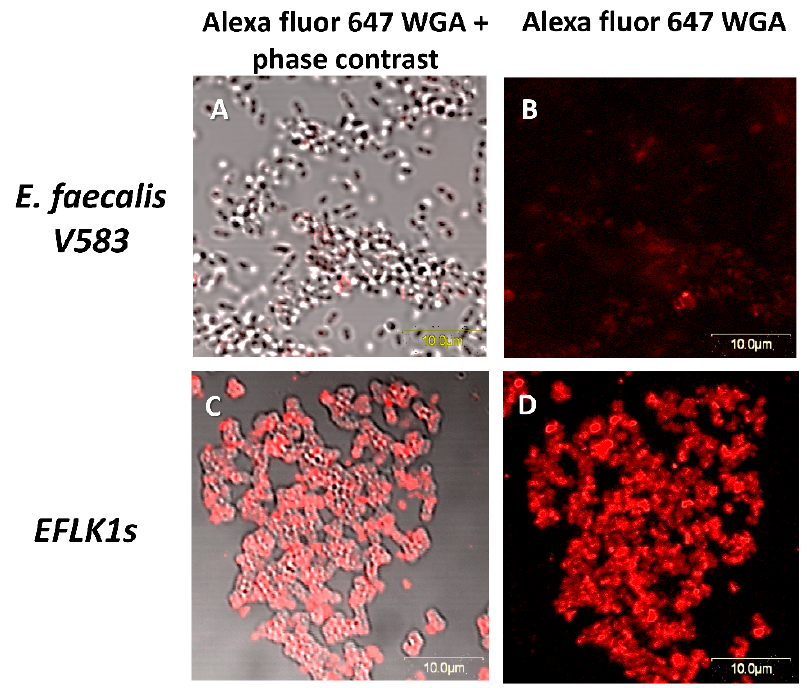
Figure 7. Alexa Fluor 647 wheat germ agglutinin (WGA) stains EFLK1 survivors . Confocal microscopy images (MAG: 60): ( A – B ) vancomycin resistant E. faecalis V583 show low fluorescence level, indicating no conjugation to N -acetylglucosamine. ( C – D ) EFLK1 survivors show high fluorescence levels followed the conjugation of Alexa Fluor 647 WGA to N -acetylglucosamine.